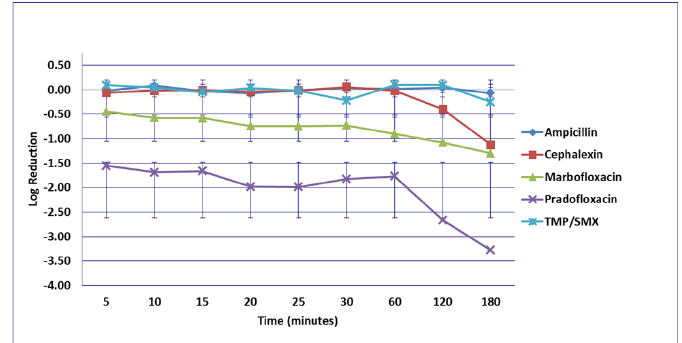
Figure 16. Log 10 reduction in S. pseudintermedius with bacterial cells exposed to ampicillin, cephalexin, marbofloxacin, pradofloxacin, and trimethoprim/sulfamethoxazole at the maximum urine drug concentration. Pradofloxacin vs. cephalexin at 20 and 30 min, p values <0.0001 and 0.00474. Cephalexin vs. marbofloxacin at 20 min, p = 0.0009. Pradofloxacin vs. TMP/SMX at 60 and 120 min, p values 0.0489 and 0.0179. Pradofloxacin vs. ampicillin at 120 min, p = 0.0348. Data points present mean ± standard deviation.